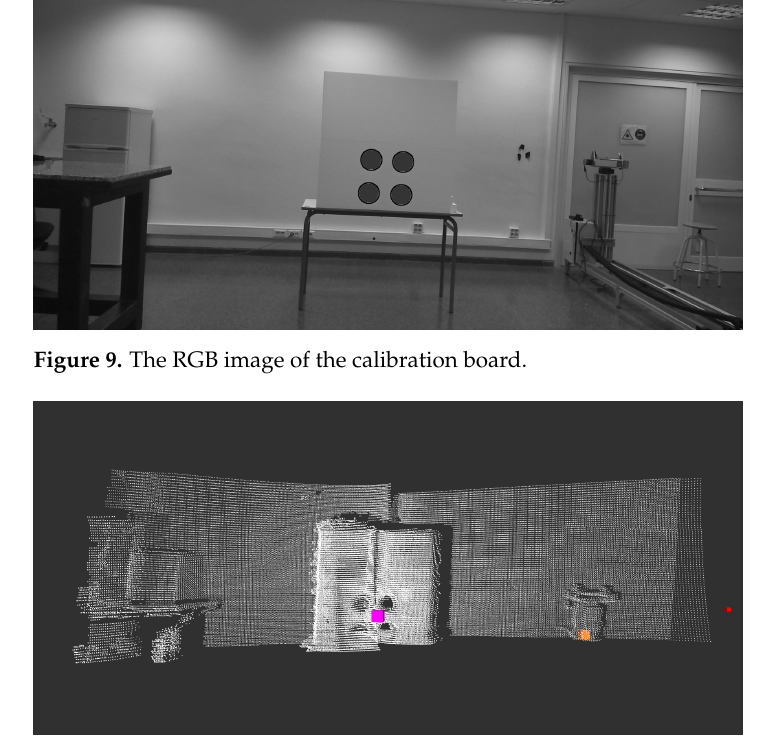
Figure 10. The lidar pointcloud is white, whereas the radar pointcloud, which is more sparse, is shown in colored cubes.